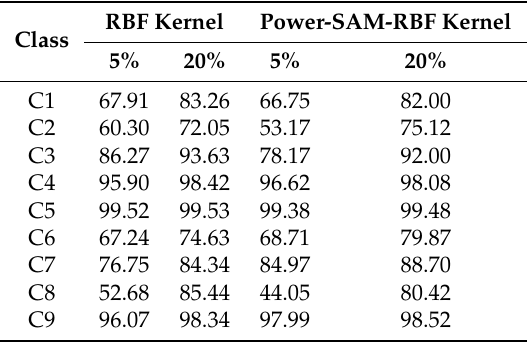
Table 10. Average product accuracy (PA) for each class with the RBF and Power-SAM-RBF kernels with 5% and 20% proportions of training